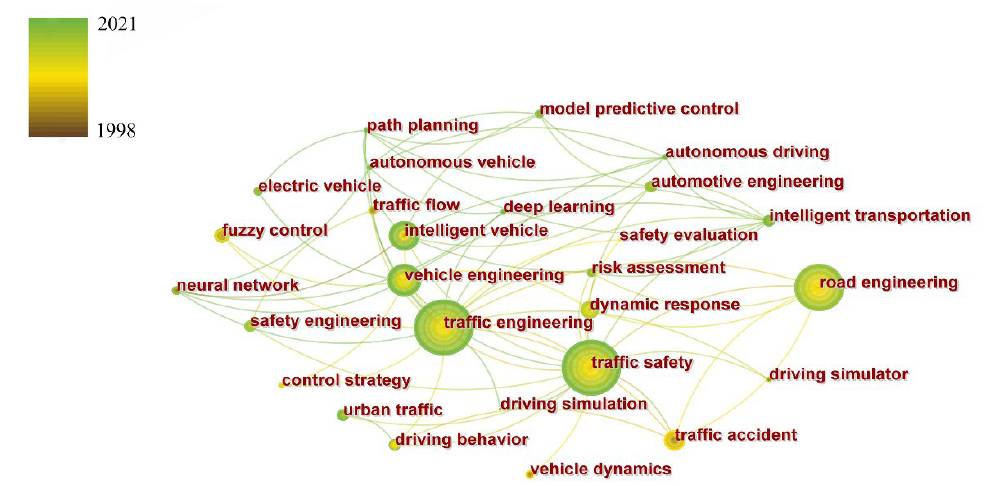
Figure 5. Co-occurrence network of partial high-frequency keywords in CSCD.